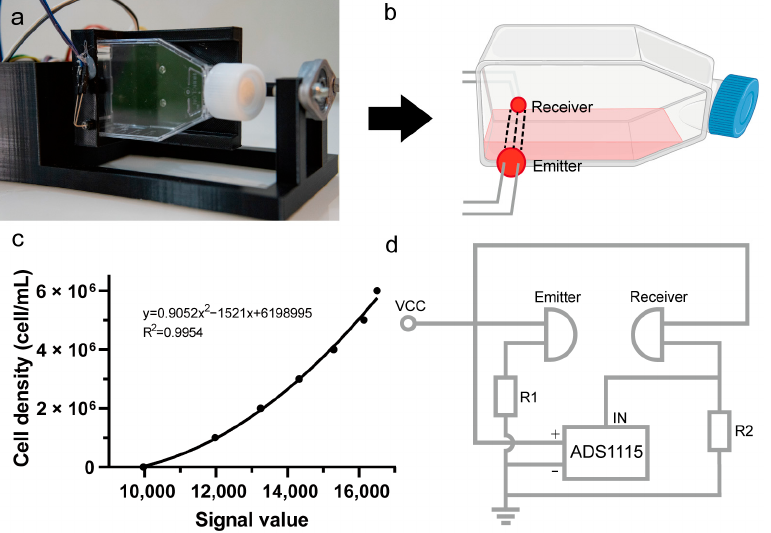
Figure 2. The working principle of the optical sensor. ( a ) The platform’s posture when cell density detection was performed. ( b ) Location of the emi tt er and receiver on the microbioreactor. ( c ) Cali- bration curve of cell density and signal values. ( d ) Circuit schematic of the optical sensor and the AD converter.